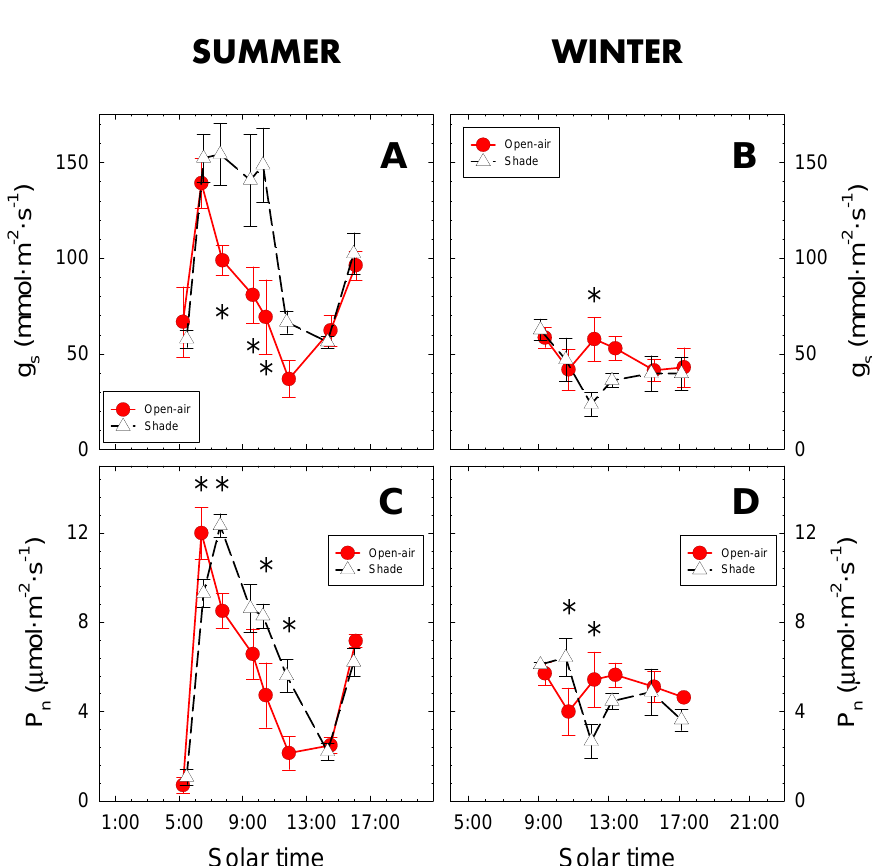
Figure 5. Diurnal course of stomatal conductance (g s ) and net photosynthesis (P n ) on representative days of summer (9 August 2018; A , C ) and winter (13 February 2019; B , D ) in lime trees grown in open-air (closed symbols) and shaded (open symbols) conditions. Each point is the average of four replications. Vertical bars represent ± standard error (SE). Asterisks indicate statistically significant differences between cropping conditions at p ≤ 0.05.